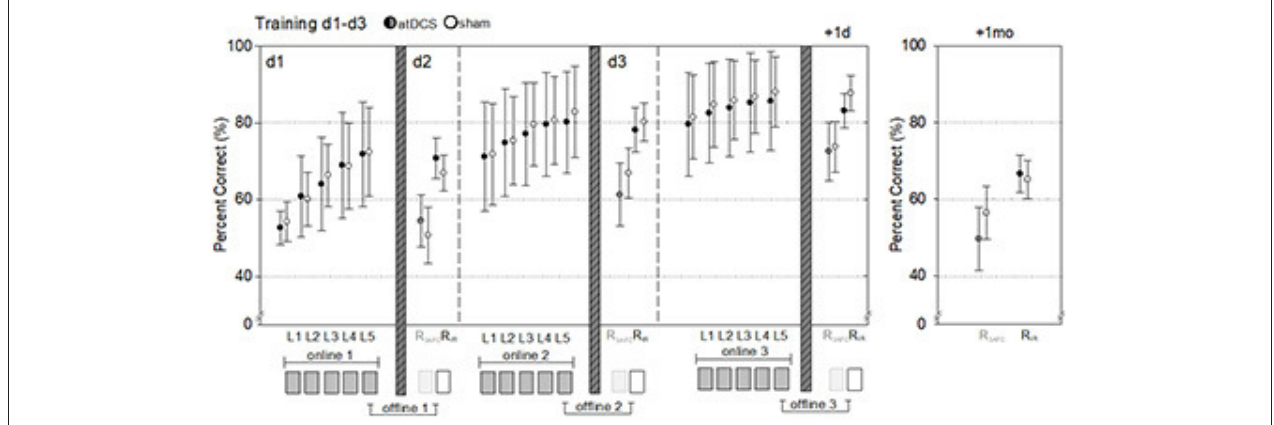
FIGURE 2 | Performance during and after object-location-memory training. Response accuracy (% correct) during each learning (L) block and overnight cued recall performance (% correct) in 3-alternative forced choice (R 3AFC ) and item recognition (R IR ) task assessed before next training on day 2 and 3 as well as cued recall at 1-day and 1-month follow-up is depicted. Dark filled circles (black, dark gray) represent performance of atDCS applied during training (“atDCS”), light filled circles represent performance of sham applied during training (“sham”). Behavioral online effects related to within-session performance and offline effects to between-session performance. Data are given as means and standard deviations. D, day; mo, month.